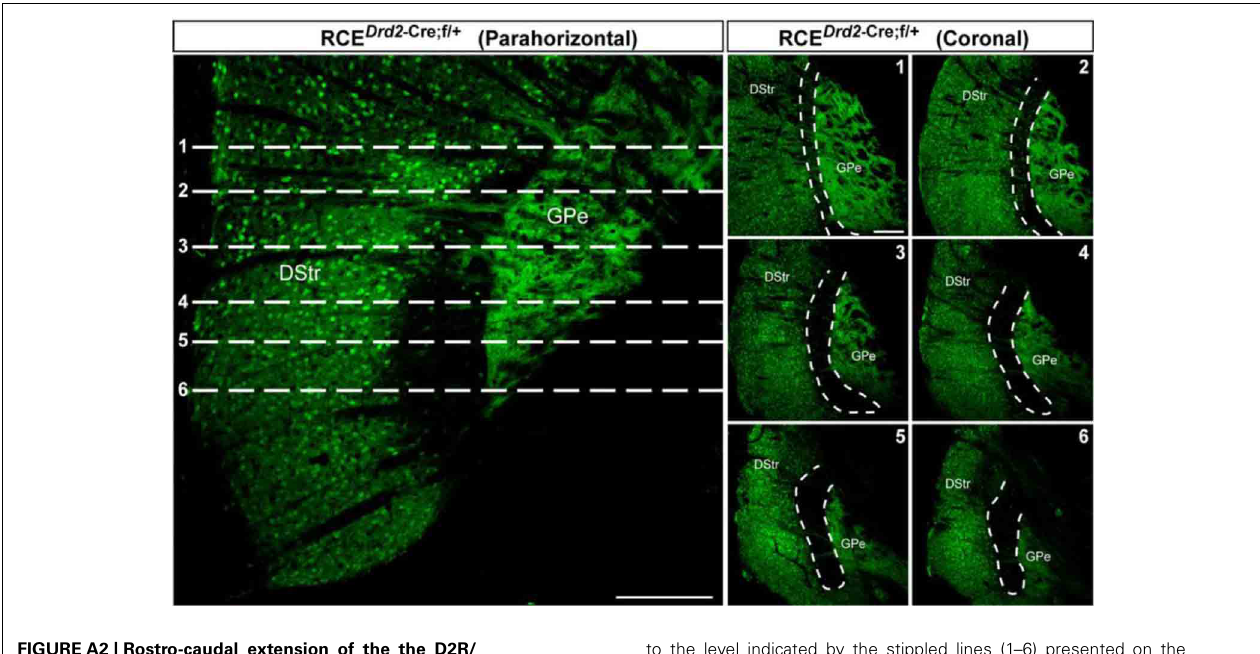
to the level indicated by the stippled lines (1–6) presented on the parahorizontal view. Scale bar, 200 μ m. Note that the size of the D2R/A2aR-expressing MSNs-poor zone progressively increases along the rostro-caudal extension. DStr, dorsal striatum; GPe, external globus pallidus, GFP, green fluorescent